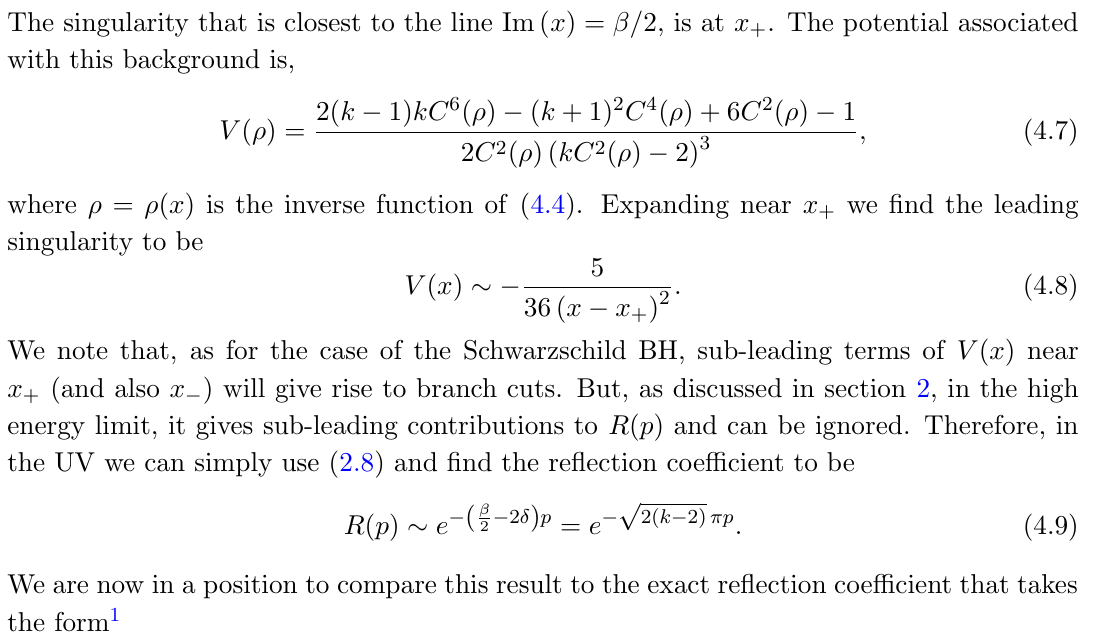
Figure 6 . Poles of the potential (4.7) in the x -plane. (cid:11) 0 perturbative corrections splits each pole of the classical potential (3.2) into three distinct ones, separated by a distance of order 1 = the large k limit). Poles marked in blue are curvature singularities, while those in red are dilaton